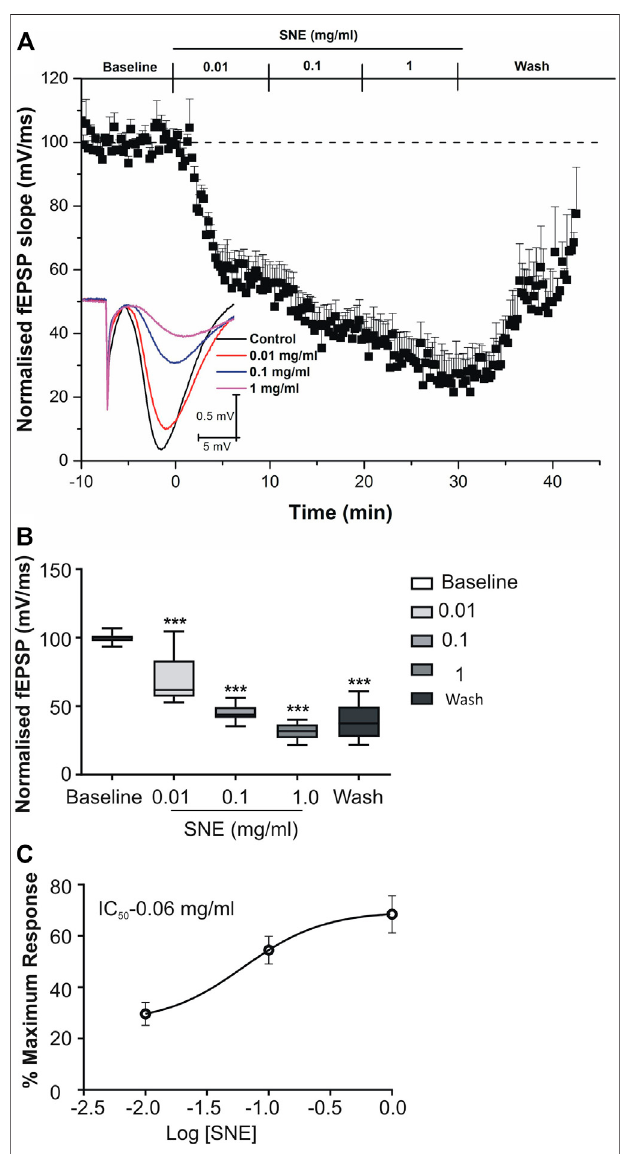
FIGURE 2 | (A) Effect of SNE (0.01, 0.1 and 1.0 mg/ml) on slope of fEPSPs in rat hippocampal slices after a stable baseline perfused with normal aCSF. (B) The bar graph represents the total effect (calculated as AUCs from the graph above). (C) Concentration-response curve from SNE (0.01, 0.1, and 1.0 mg/ml) on slope of fEPSPs. Data is mean ± SEM (n (cid:2) 5). *** p < 0.001 compared with baseline, one-way ANOVA followed by a Dunnett ’ s multiple comparison